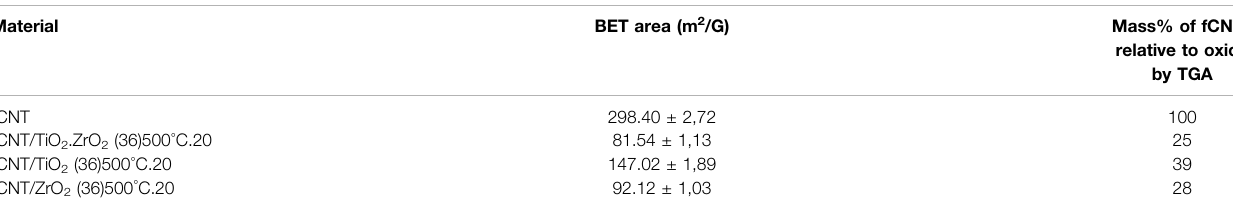
TABLE 3 | Surface area BET of the nanostructured materials.